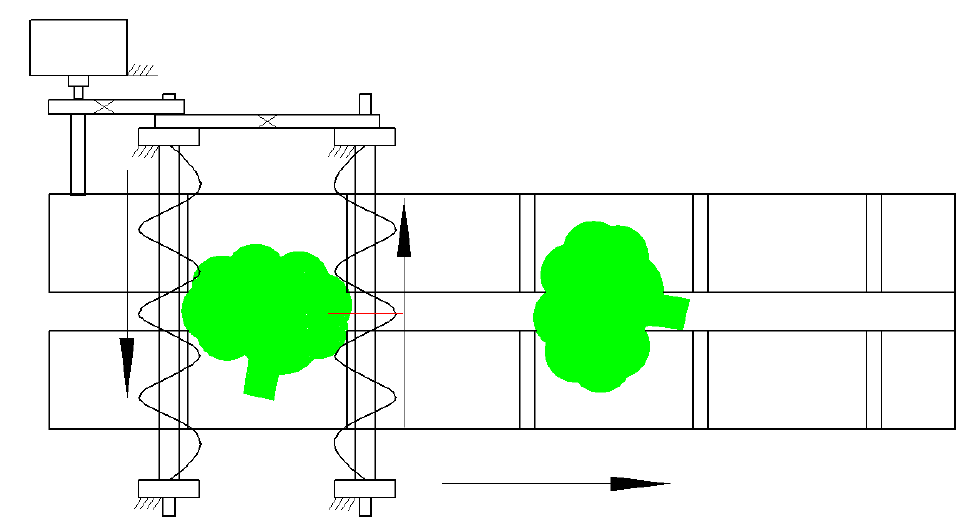
Figure 11. Schematic diagram of the operation of the double spiral adjusting mechanism.